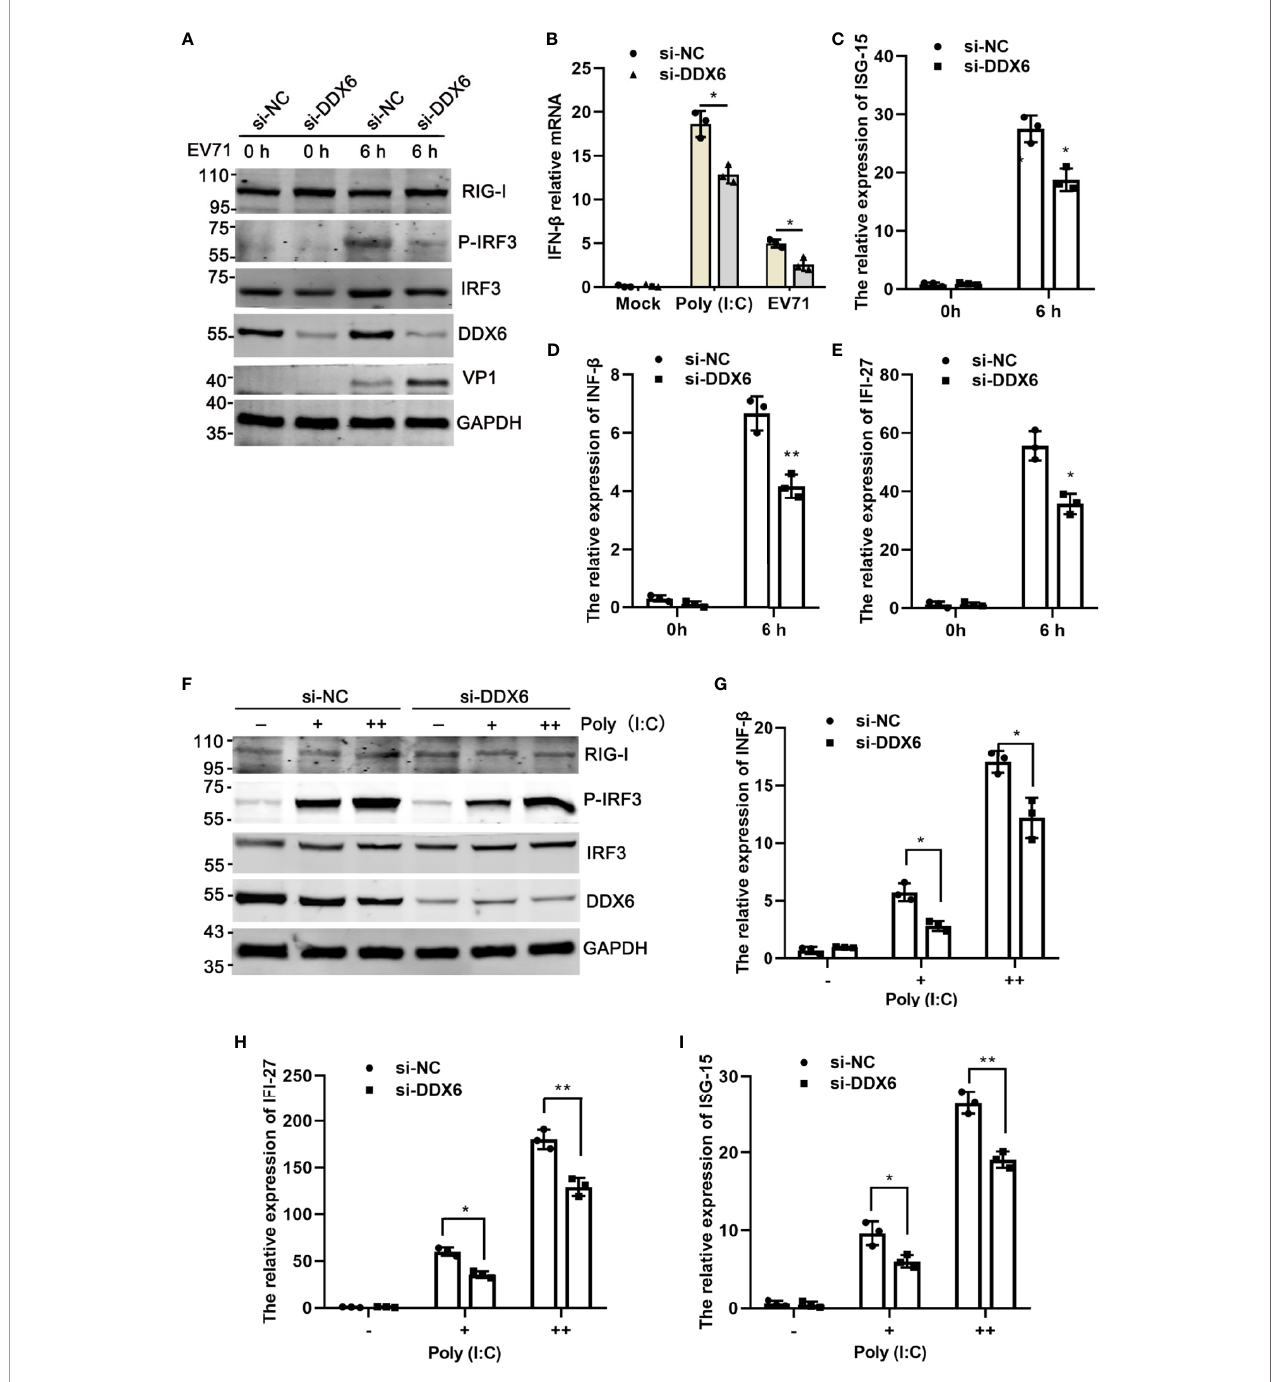
FIGURE 4 | Knockdown of DDX6 reduced I-IFN activation during EV71 infection. (A) HeLa cells were transfected with si-NC or si-DDX6 for 48 h and then infected with EV71 6 h p.i., then was analyzed by western blot with the indicated antibodies (RIG-I, P-IRF3, IRF3, DDX6, and VP1). GAPDH was used as a control. (B) After Poly (I: C) and EV71 stimulation, the relative expression of exogenous IFN- b was detected by real time-PCR in si-DDX6 and si-NC transfected cells. (C – E) The mRNA levels of IFN- b , IFI-27, and ISG15 were analyzed by real-time PCR and normalized to GAPDH. (F) HeLa cells were treated with si-NC or si-DDX6 for 48 h and treated with or without poly (I:C) (+/++ represent 200 ng and 500 ng, respectively) for 12 h, western blot analysis of cell lysates with antibodies speci fi c for RIG-I, MAVS, P-IRF3, IRF3, DDX6, and GAPDH. (G – I) The relative mRNA expression of IFN- b , IFI-27, and ISG15 was determined by a real-time PCR assay. The results are presented as means with SD (* P < 0.05, ** P <